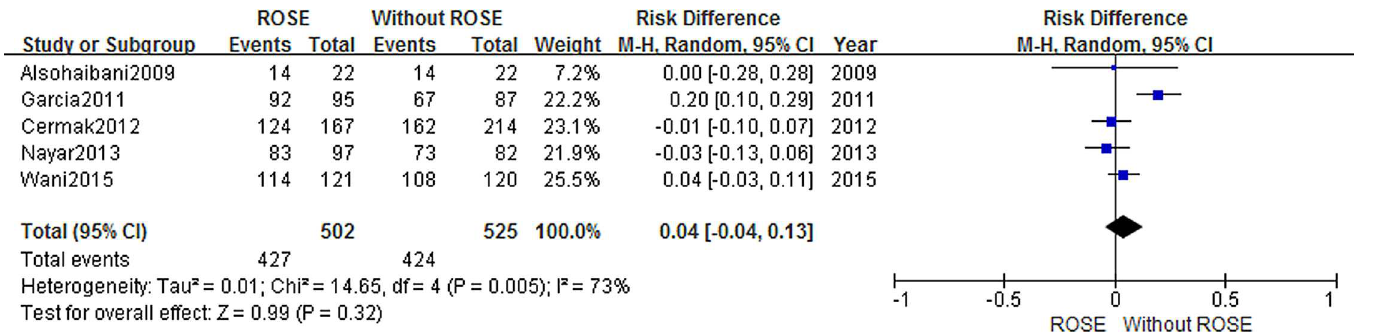
Fig 4. Forest plot displaying the Risk Difference and 95% CIs of each study for the diagnosis